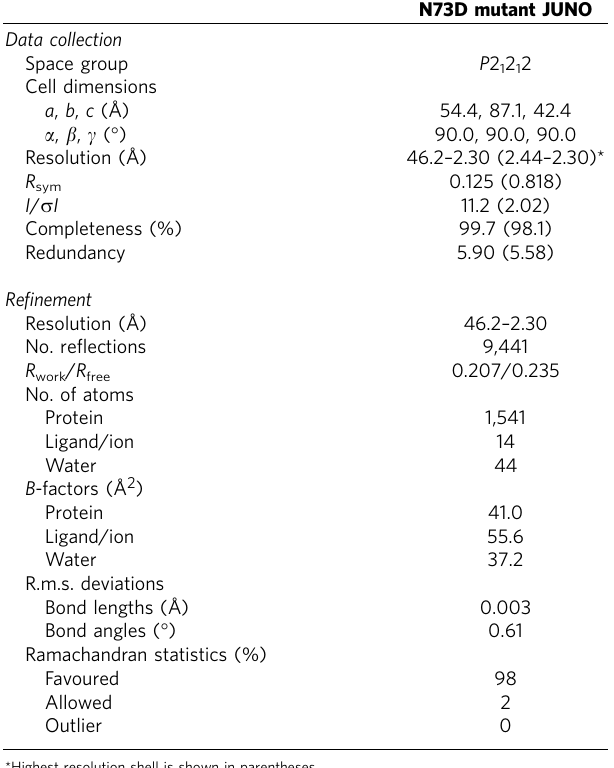
Table 1 | Data collection and refinement